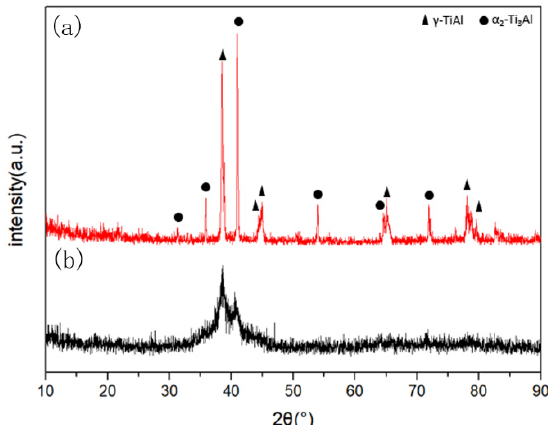
Figure 2. XRD spectra of TiAl powder: ( a ) primary powder, ( b ) ball-milled powder for 15 h (particle size = 26 μ m).